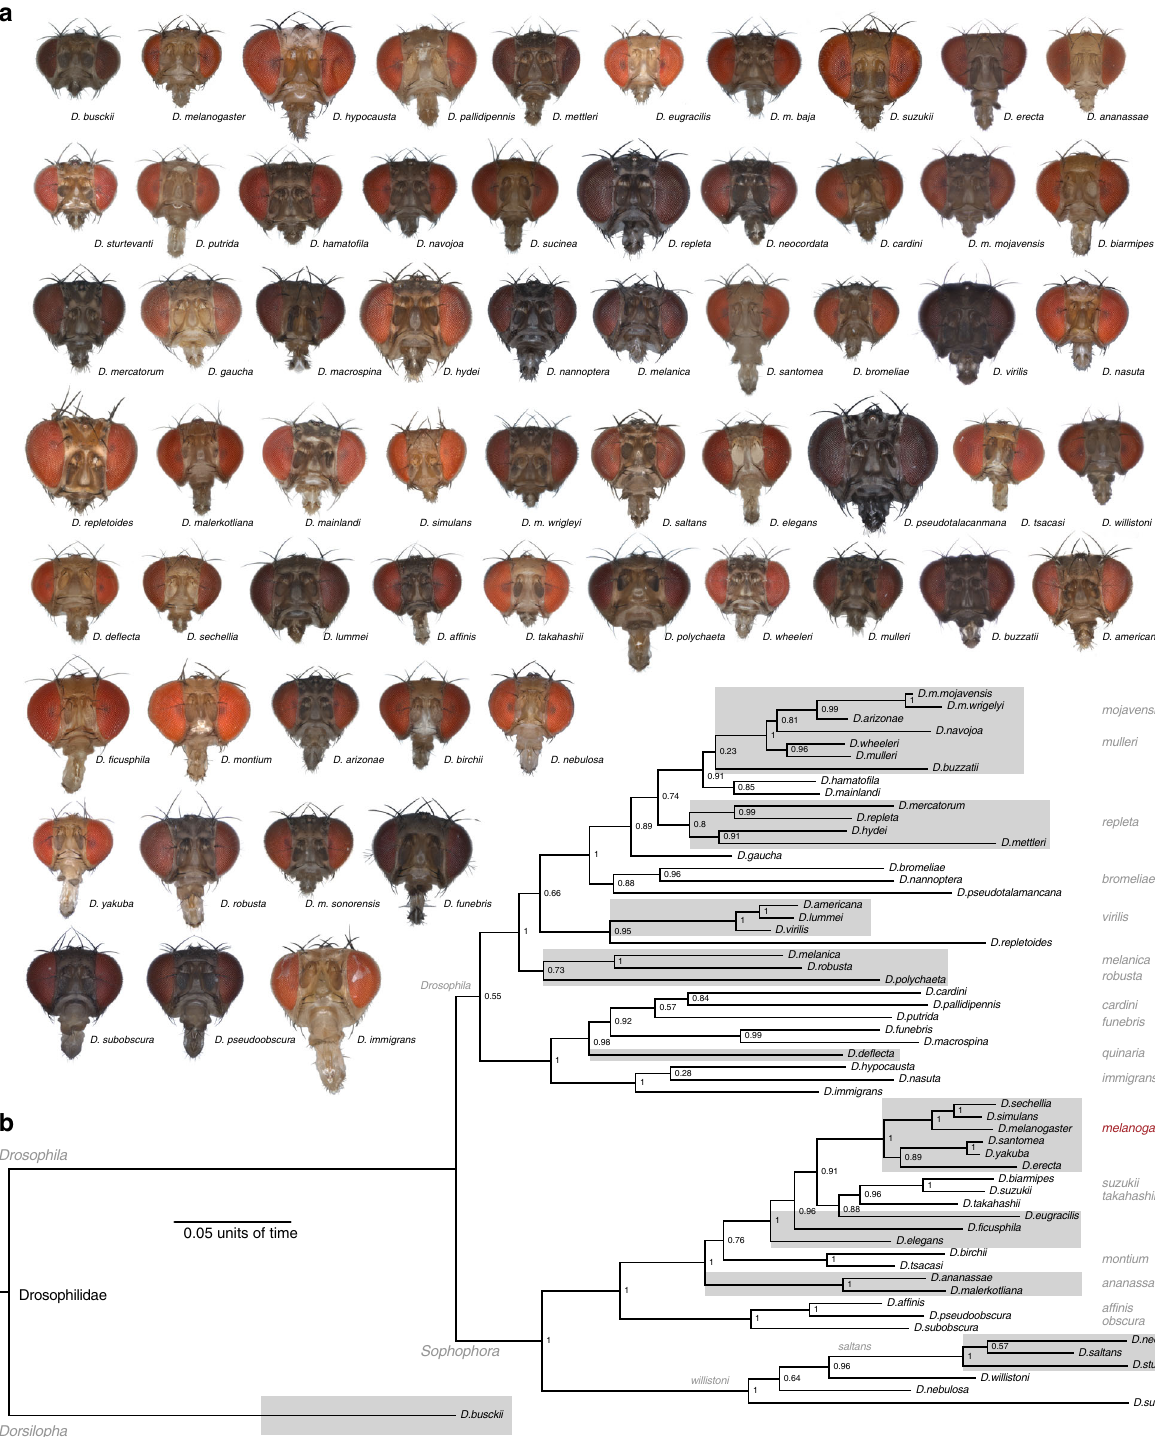
Fig. 1 Frontal head images of all tested Drosophila species and their associated phylogeny. a Frontal view of the head of all 62 species, illustrating the diversity in overall size, as well as in the variance of the visual and olfactory sensory systems across this genus. Also worth noting is the disparity in pigmentation that extends across the whole head, including the antenna and the compound eye. b Phylogeny of 59 species of Drosophila where genetic material was available for use in this study ( D. montium and two subspecies of D. mojavensis are missing). Species were selected to span the width of subgroups and represent the genetic diversity within this genus of insect. Some species are denoted with gray boxes to provide more visual separation between subgroups. (Data are provided at